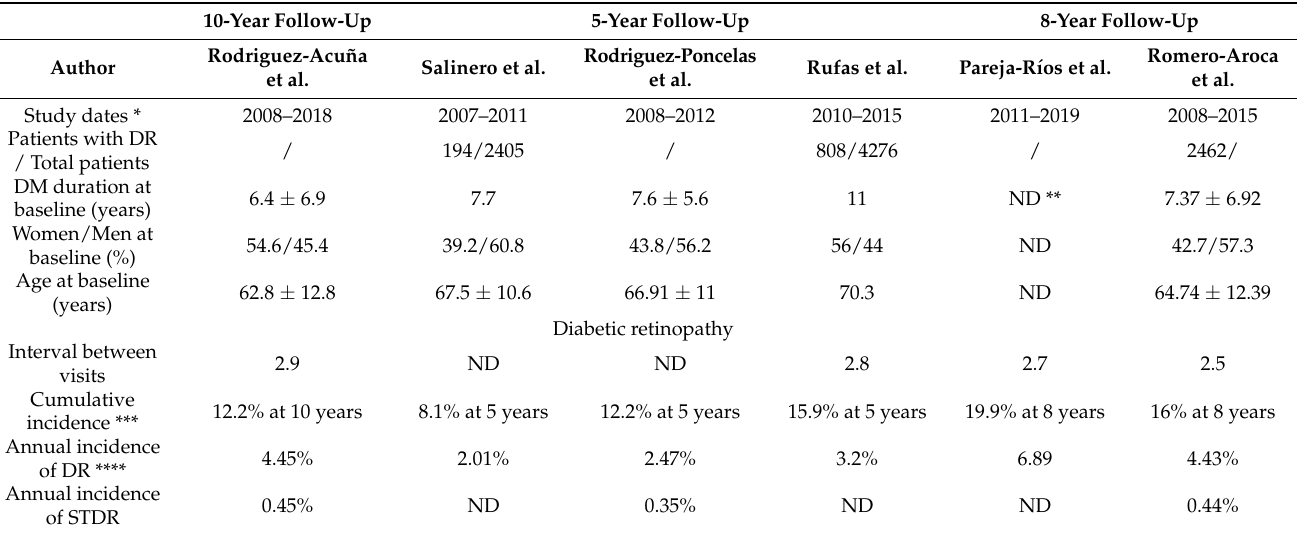
Table 2. Diabetic Retinopathy Outcomes and Demographics from Longitudinal